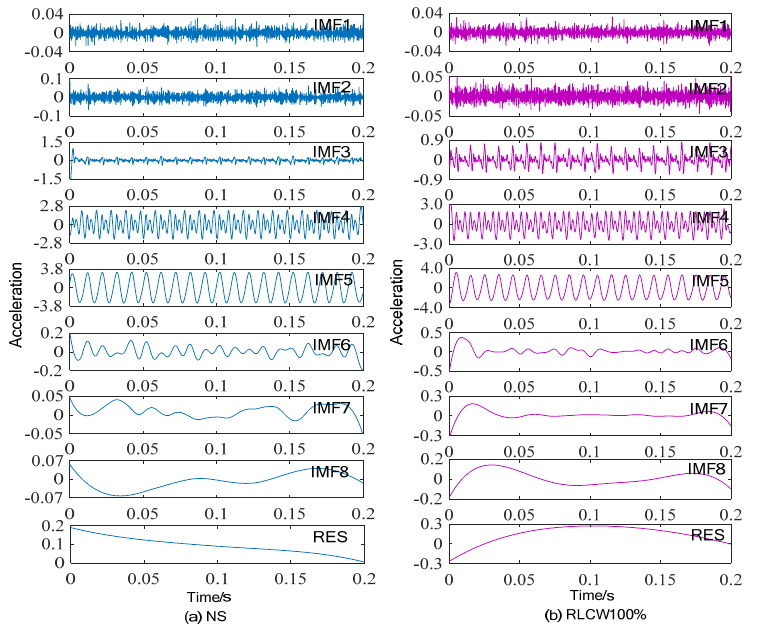
Figure 9. MCPCEEMD calculation results of NS and RLCW100%.